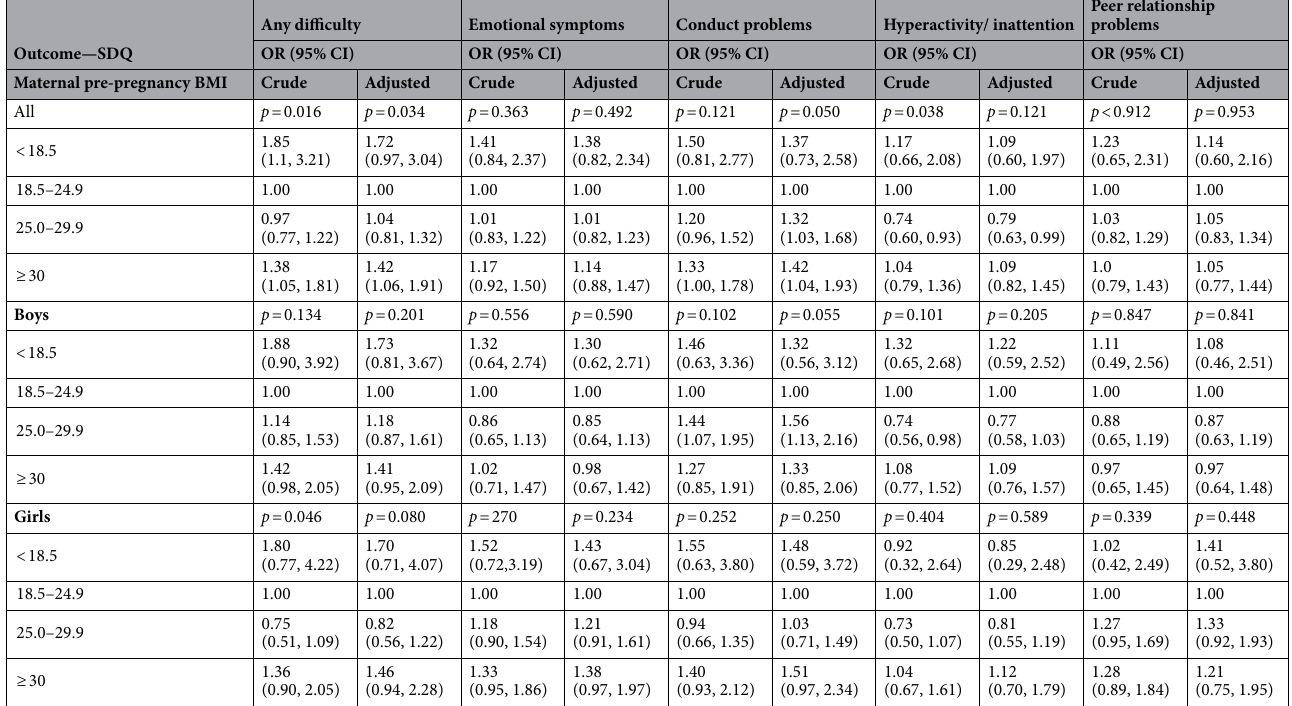
Table 4. Logistic regression associations between maternal pre-pregnancy body mass index (BMI) and children’s mental problems at 11 years of age. a Adjusted for child’s sex, maternal age, skin color,